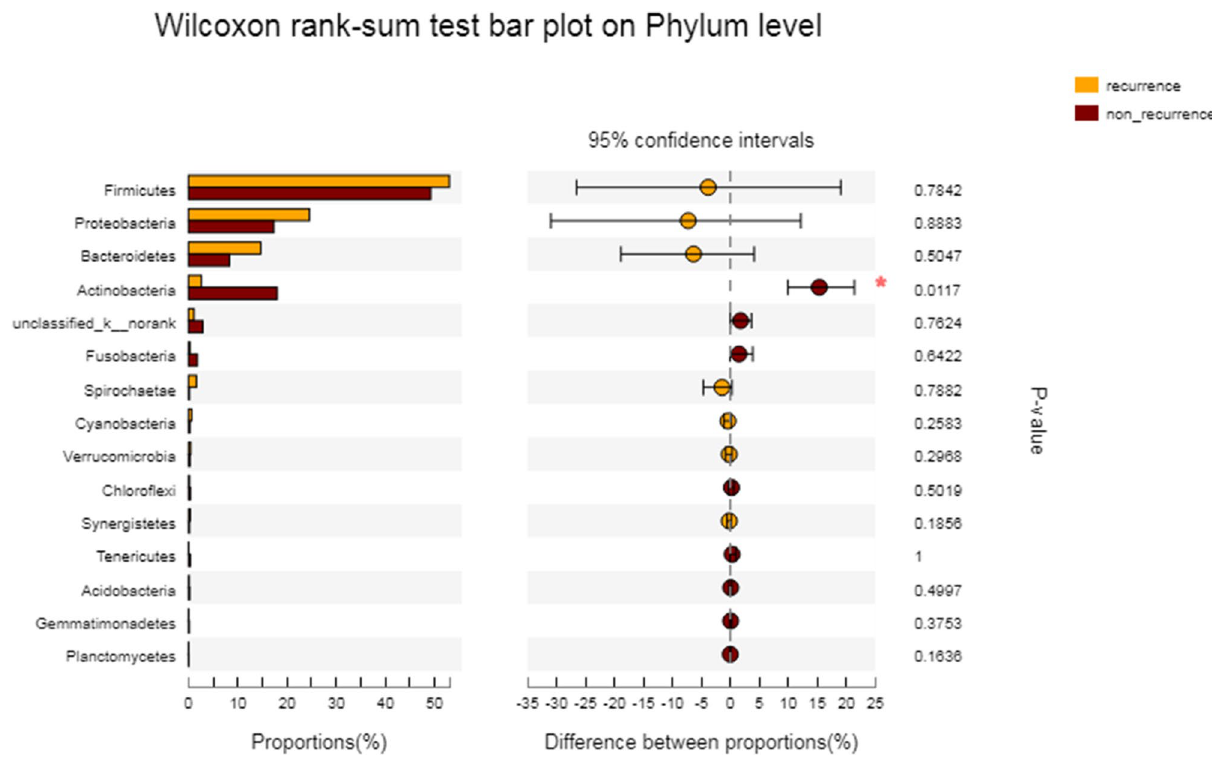
Figure 4. The Wilcoxon rank sum test was used to compare the difference in nasal microbial colony composition between the recurrent and non-recurrent nasal polyp patients at the phylum level.